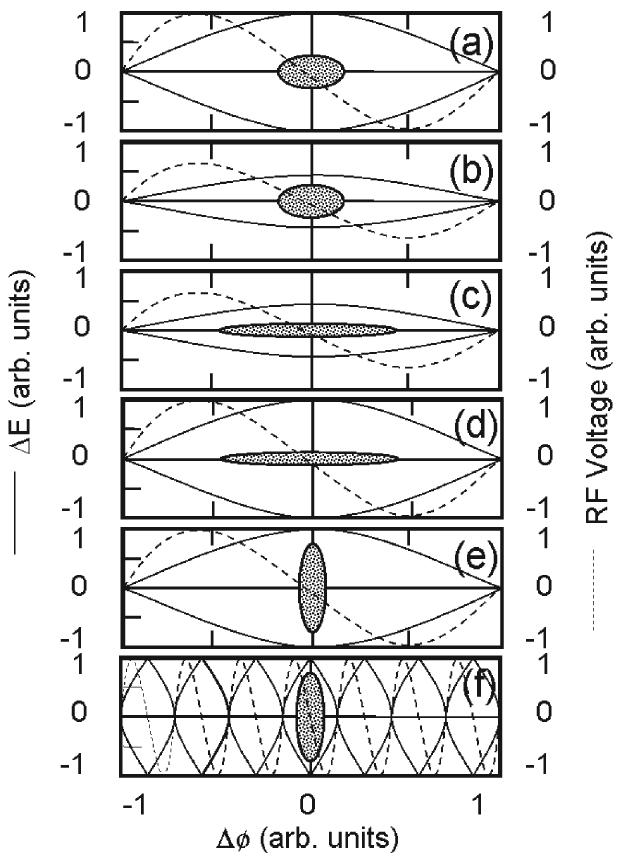
FIG. 2. Schematic view of the synchronous transfer of a bunch in a bucket of lower harmonic number to that with higher harmonic number. The solid lines and dashed lines represent the rf bucket contours and rf waveforms, respectively. (cid:2) (cid:1) E; (cid:1) (cid:5) (cid:3) -phase distributions of beam particles (bunch shown in the middle of each bucket) shown for each stage are as follows: (a) beam particles in a bucket after the end of first acceleration (at this stage generally the V is large); (b) the rf voltage is brought down quickly to a smaller value so that the bucket height is slightly larger than the beam height (bunch is not matched to bucket); (c) after a quarter synchrotron period; (d) after rapid increase of the rf voltage; (e) after a quarter synchrotron period; (f) after capture in buckets of higher har- monic